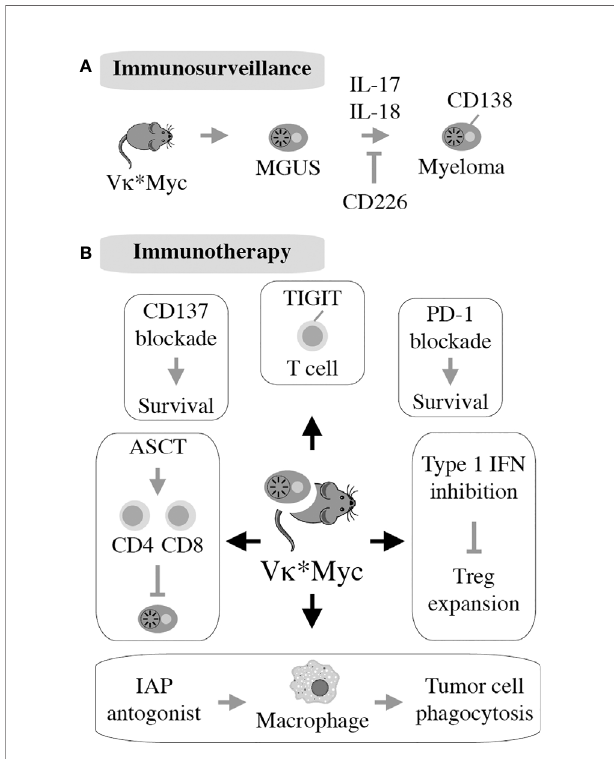
FIGURE 6 | First described in 2008, the Vk*MYC model takes advantage of AID-activated MYC to induce myeloma on the B6 background. All 122 mice in the original study had monoclonal plasma cell expansion in the BM resembling human MM. Eighty percent of mice had measurable M-spike by 50 weeks of age. Additionally, aged Vk*MYC mice displayed many hallmarks of human MM, including bone loss and protein deposition in the kidneys (150). This allows for thorough studies of the MGUS to MM transition in this model (A) . Vk*MYC mice accurately predict clinical ef fi cacy of myeloma drugs (151) and provide a good model for experimental oncolytic immunotherapy (152) (B) ( Figure 6B ). The impressive body of work summarized above strongly suggests that Vk*MYC provides a valuable blueprint for immunological studies using other mouse myeloma models included in Table 1 .